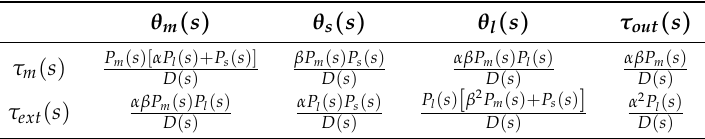
Table 5. Transfer functions of generalized platform of